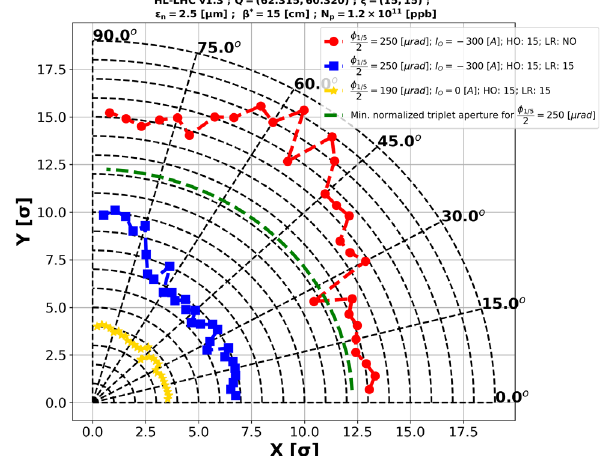
FIG. 2. Dynamic aperture vs crossing angles at the end of the luminosity leveling. For the case of only head-on collision at IP1 and IP5 is the red line, the case of head on plus BBLR kicks and 250 μ rad half crossing angle is the blue line, while with 190 μ rad is the yellow line. The minimum normalized triplet aperture for the HL-LHC baseline scenario is shown in green.